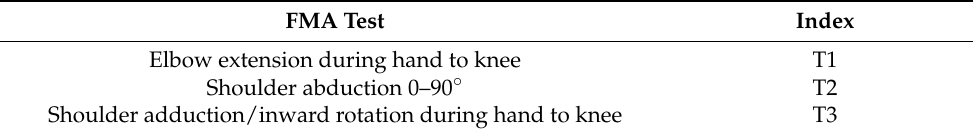
Table 1. Target FMA